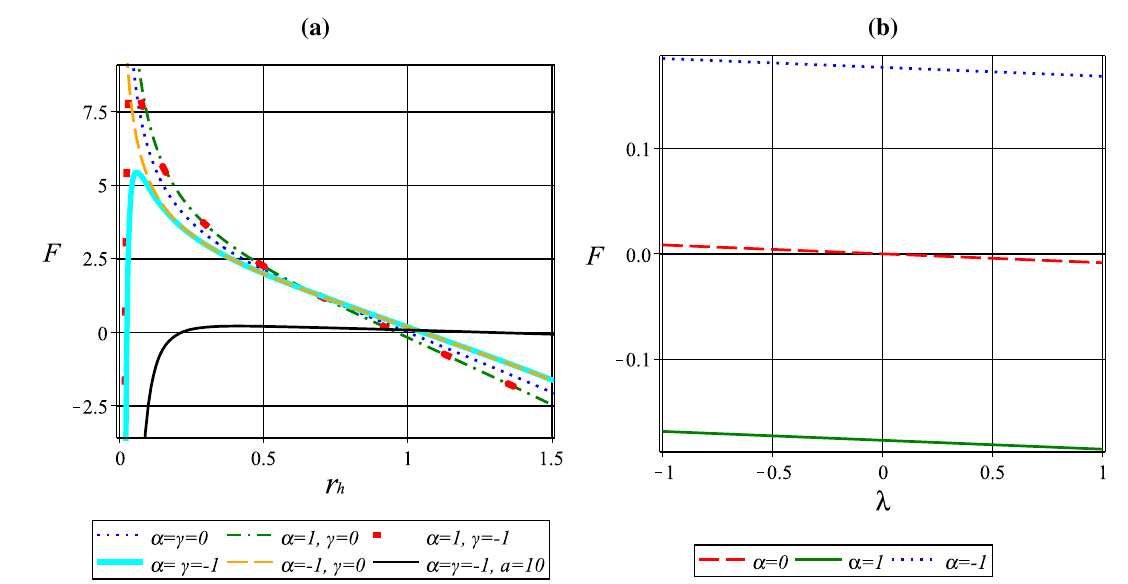
Fig. 1 Helmholtz free energy of the LMP solution of HL black hole in spherical space for l = a = 1. a In terms of horizon radius, b in terms of the second order correction parameter with r h = 1